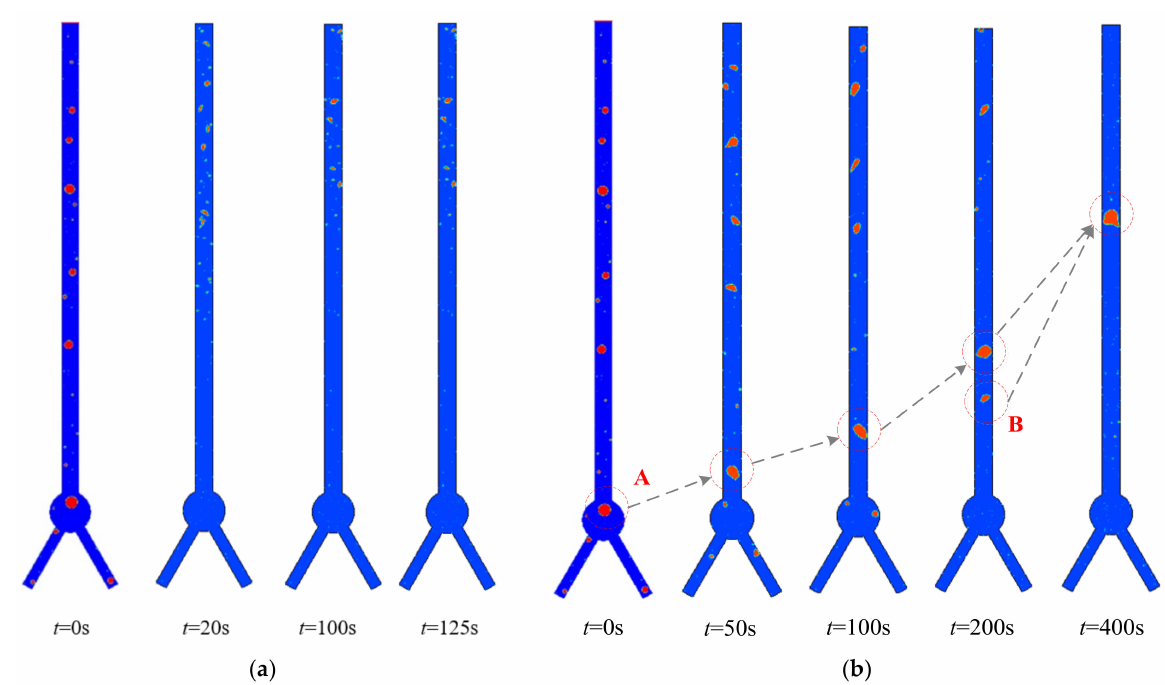
Figure 5. Bubble rise features under 10 − 2 g 0 and 10 − 3 g 0 ( t 0 = 60 min). ( a ) 10 − 2 g 0 ; ( b ) 10 − 3 g 0